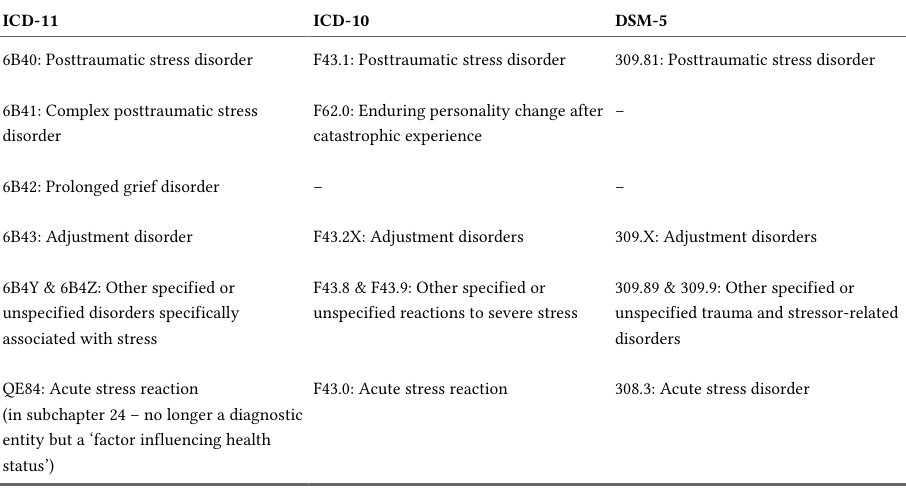
Disorders Related to Stress and Trauma According to the ICD-11, the ICD-10, and the DSM-5